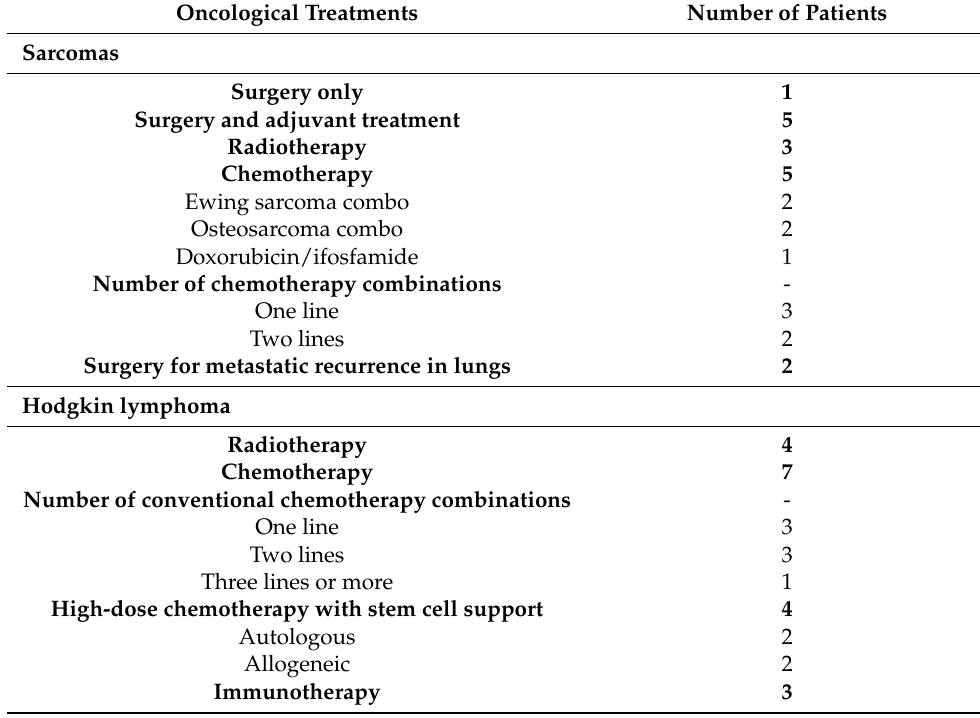
Table 2. Oncological treatments. Oncological